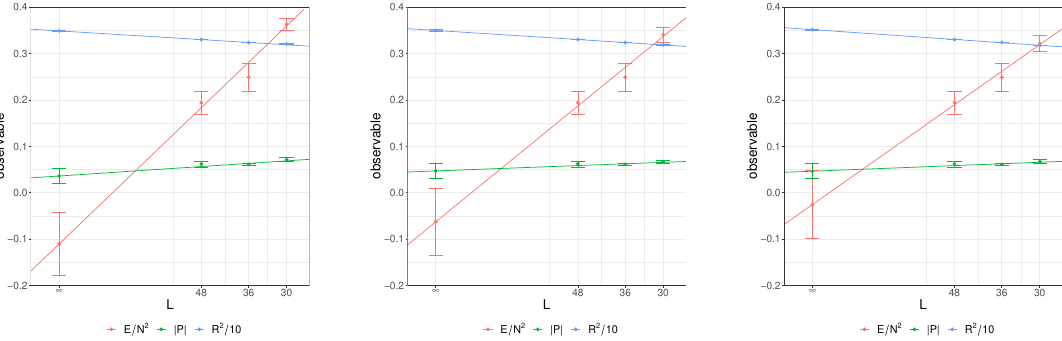
Figure 32. BFSS at T = 0 . 2 , continuum extrapolations in the confined phase for N = 16 . Trajectories for L = 30 , N = 16 were discarded if R 2 was greater than a certain cutoff value. From left to right: no cutoff, R 2 ≤ 3 . 23 , R 2 ≤ 3 . 21 . We observe that the continuum value of the